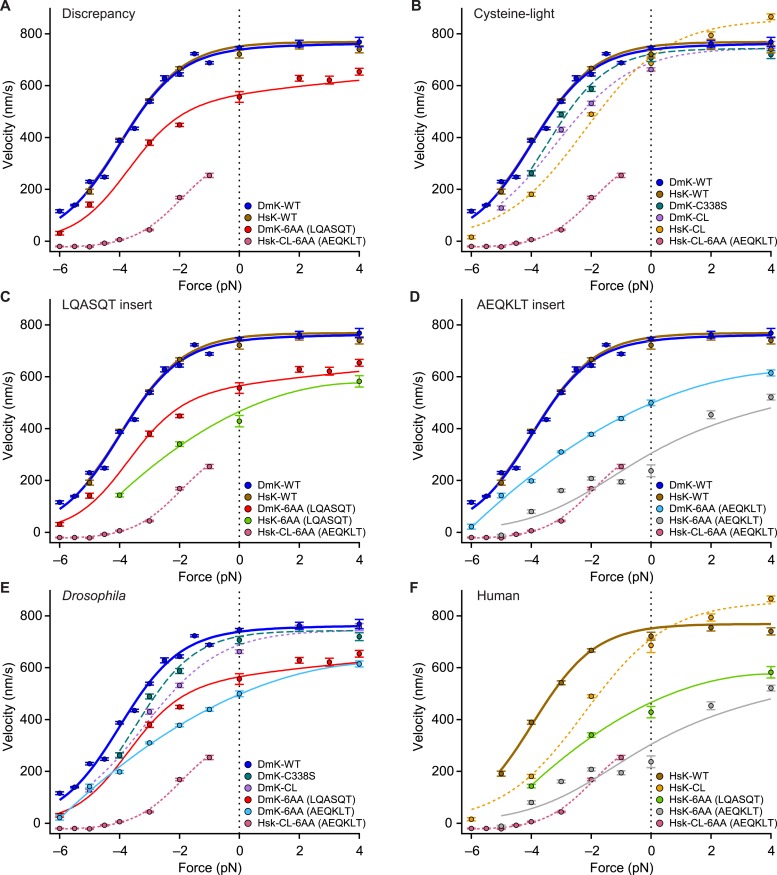
Kinesin motility characteristics depend upon parent species, NL length, NL sequence, and cysteine mutations.Force–velocity relations of constructs that differ by parent species, NL length, NL insert sequence, or cysteine mutations (mean ± SE; N = 25–818; solid circles, color-coded according to the legends). (A) DmK-6AA exhibited lower velocity under all loads than WT, but was faster and less force-dependent than HsK-CL-6AA, a human CL construct with a different 6-AA NL insert. (B) Side-by-side comparison of human and Drosophila CL mutants, along with corresponding WT constructs. Unloaded velocities of CL constructs with WT-length NL domains were similar, but CL constructs were systematically slower than WT under hindering loads. Under assisting loads, only the HsK-CL construct could be sped up beyond WT velocities. (C and D) Comparisons of constructs carrying NL insert sequences LQASQT (C) and AEQKLT (D). Force–velocity data for WT Drosophila and human kinesin were indistinguishable, but human constructs with 6-AA extensions of the NL moved at lower velocities than corresponding Drosophila motors under all loads. (E and F) Comparisons of all Drosophila (E) and human (F) constructs. Constructs with the NL insert AEQKLT were slower for all forces than those with LQASQT, for both Drosophila and human kinesin. HsK-CL-6AA data (Clancy et al., 2011) and hindering-load velocities for DmK-WT (Andreasson et al., 2015) are reproduced from previous work. Fits to DmK-WT and DmK-6AA data sets (solid lines; color-coded according to the legends) correspond to the model of Figure 5, with parameters values from Table 2. The remaining force–velocity data were fit to polynomials (solid and dashed lines; color-coded according to legends), provided to guide the eye.